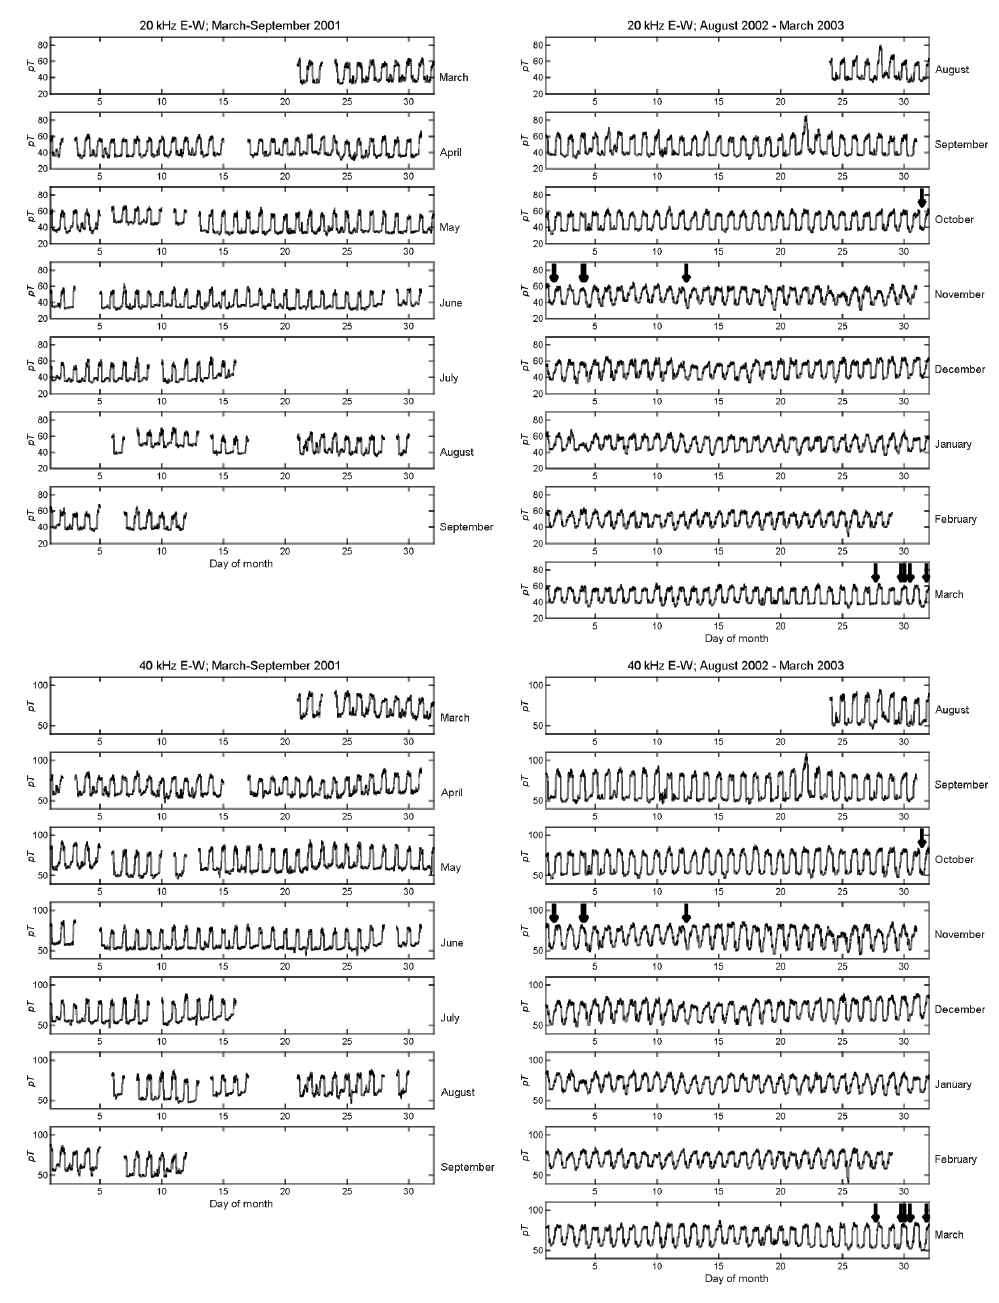
Fig. 7. VLF 20 kHz and 40 kHz data (1 min averages) for the time periods March-September 2001 and Sep- tember 2002-March 2003. The arrows indicate the earthquake ( M d >= 4)